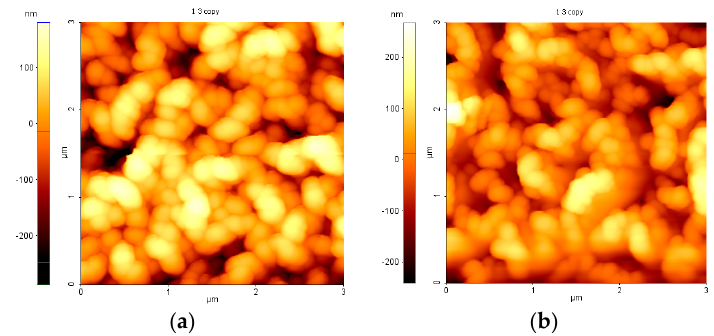
Figure 9. The topography of CNW after fluorocarbon plasma exposure with ( a ) 8 sccm (Root Mean Square (RMS) 69.7 nm); and ( b ) 16 sccm (RMS 80.2 nm) of C 2 H 2 F 4 .